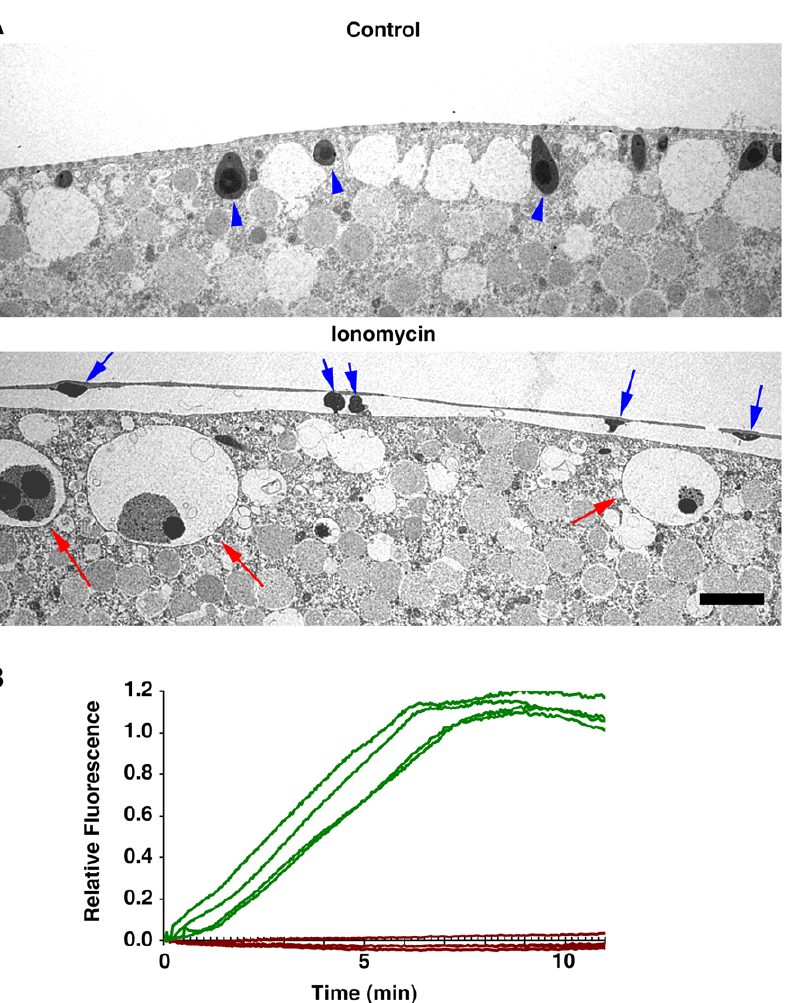
Figure 4. Disruption of cortical granules and microvilli by the brief exposure to ionomycin leads to depletion of the ionomycin- sensitive Ca 2 + stores. A. aranciacus oocytes at the GV stage were exposed to 5 m M ionomycin for 3 min before switched to the media containing 1- MA. ( A ) After 1 h incubation, the mature eggs were fixed with glutaraldehyde and analyzed by TEM. Blue arrows indicate the remnant of the cortical granules that were extruded in the perivitelline space. Red arrows indicate fragments of cortical granules being engulfed by white vesicles. Scale bar=10 m m. ( B ) The same batch of oocytes were exposed to 5 m M ionomycin for 3 min and switched to the fresh media containing 1-MA. After GV breakdown, the mature eggs were microinjected with Calcium Green/Rhodamine Red and subsequently re-exposed to 5 m M ionomycin (t=0) to monitor the Ca 2 + response. The trajectory of intracellular Ca 2 + levels in the eggs with or without (control) ionomycin pretreatment were depicted in brown and green curves, respectively.